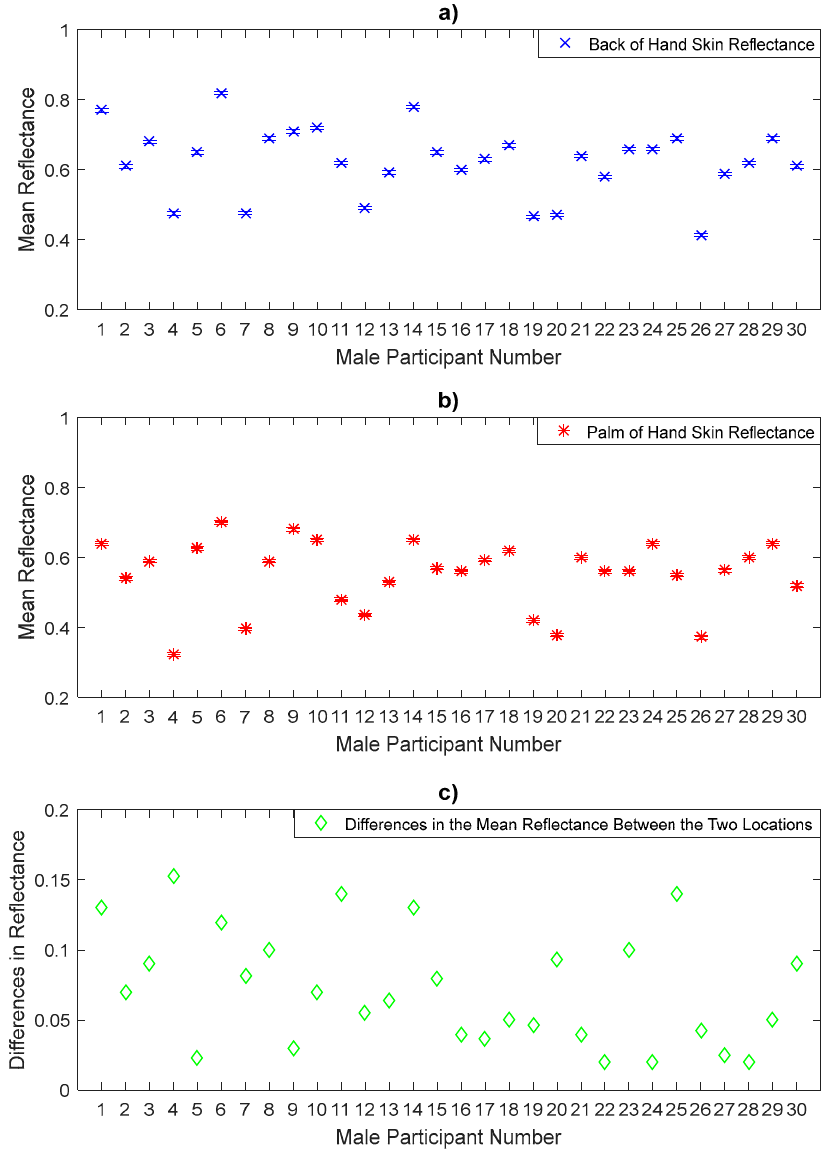
Figure 8. Measurements of human skin reflectance on the back of hand ( a ) and the palm of hand skin ( b ) for a sample of 30 male participants. The mean differences in reflectance values between the two locations ( c ) are in the range of 0.02 to 0.153.